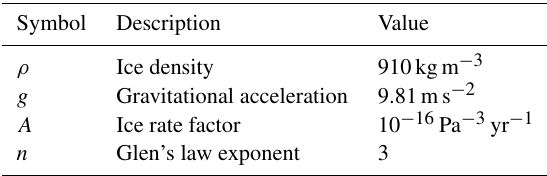
Table 1. Constants used in the ISMIP-HOM